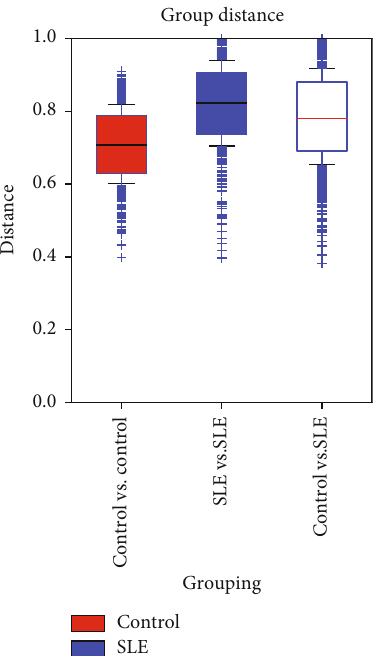
Figure 1: Bray-Curtis statistical algorithm was used to calculate the distance between each sample and obtain the distance matrix. The distance between the SLE group and the HC group with quartiles was calculated, and a box diagram of the distance between the two groups was drawn to compare the distance distribution di ff erences. Student ’ s two-sample t -test method was used to compare the distance between each